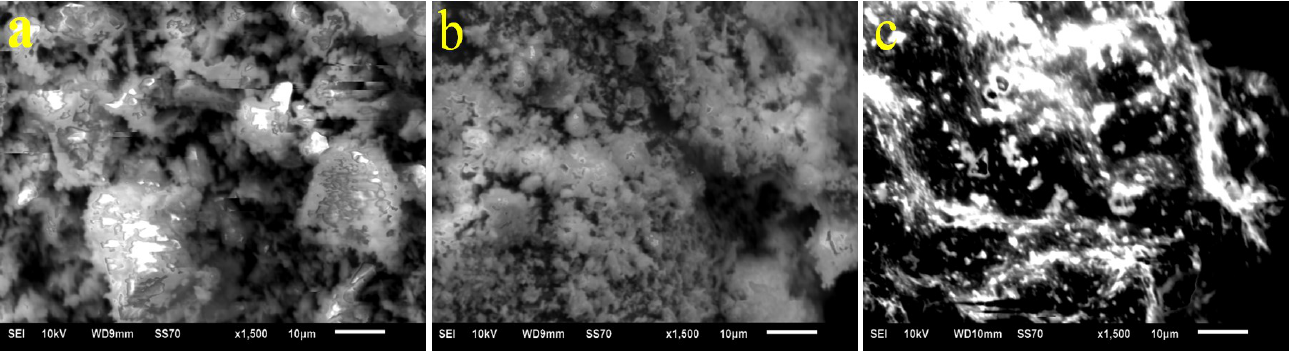
Figure 13. SEM images of the luminescent samples synthesized after adding ( a ) EA; ( b ) PVA; ( c )